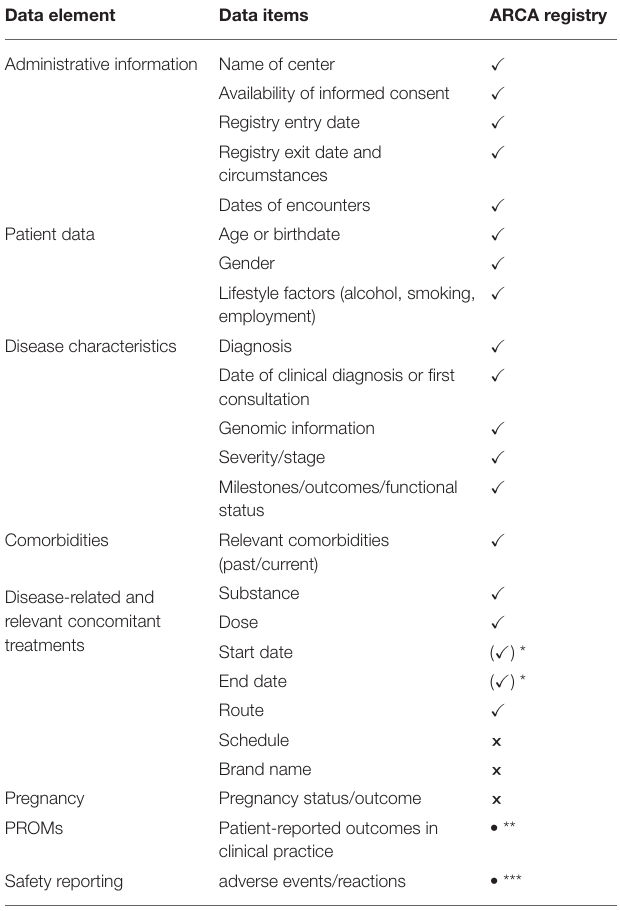
TABLE 2 | Implementation of EMA guidelines on patient